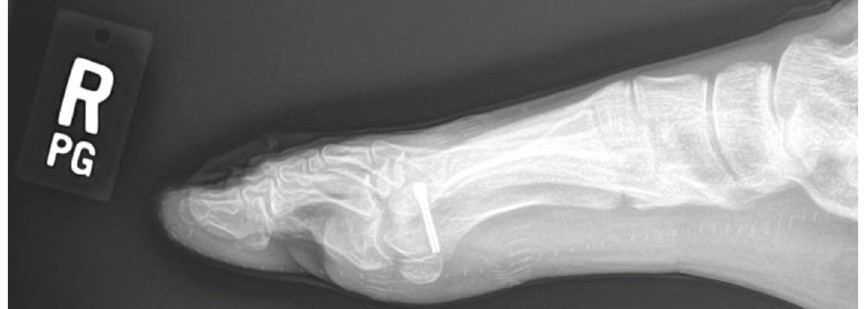
Figure 6: Postoperative lateral radiograph of the right foot demonstrating hallux rigidus correction with OCA implantation on the metatarsal head.